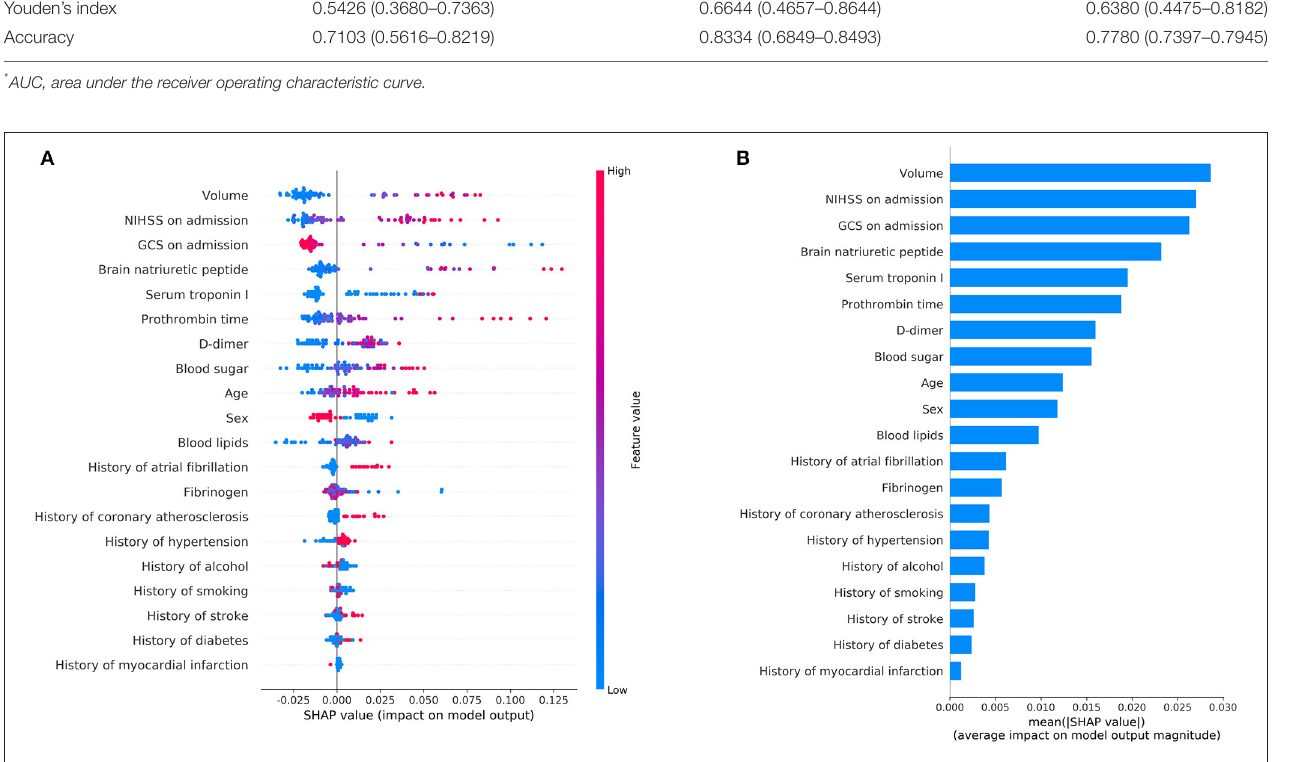
FIGURE 6 | Shapley additive explanation (SHAP) diagram of variable contributions for the optimal predictive model, i.e., the random forest classifier with volume + clinical data. (A) The relative contributions of AI-derived volumes and clinical variables for progression prediction. Features on the right of the risk explanation bar pushed the risk higher, and features on the left pushed the risk lower: a patient with a larger volume, higher NIHSS, and lower GCS is at a higher risk. (B) The relative contributions of variables for progression prediction quantified with the mean of the absolute SHAP